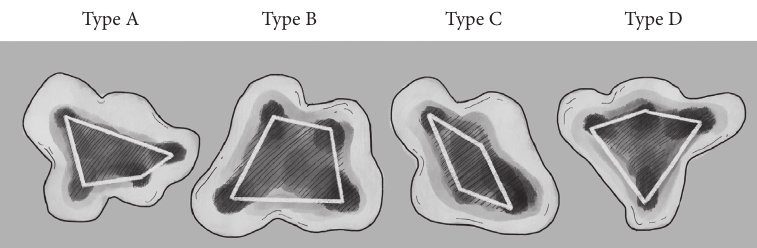
Figure 2: Schematic drawing of Versiani’s configuration of canal orifices in four-rooted maxillary second molars [14]. The orifices were classified in relation to the pulpal chamber floor as Type A (irregular quadrilateral-shaped), Type B (trapezoid-shaped), Type C (lozenge- shaped), and Type D (kite-shaped).